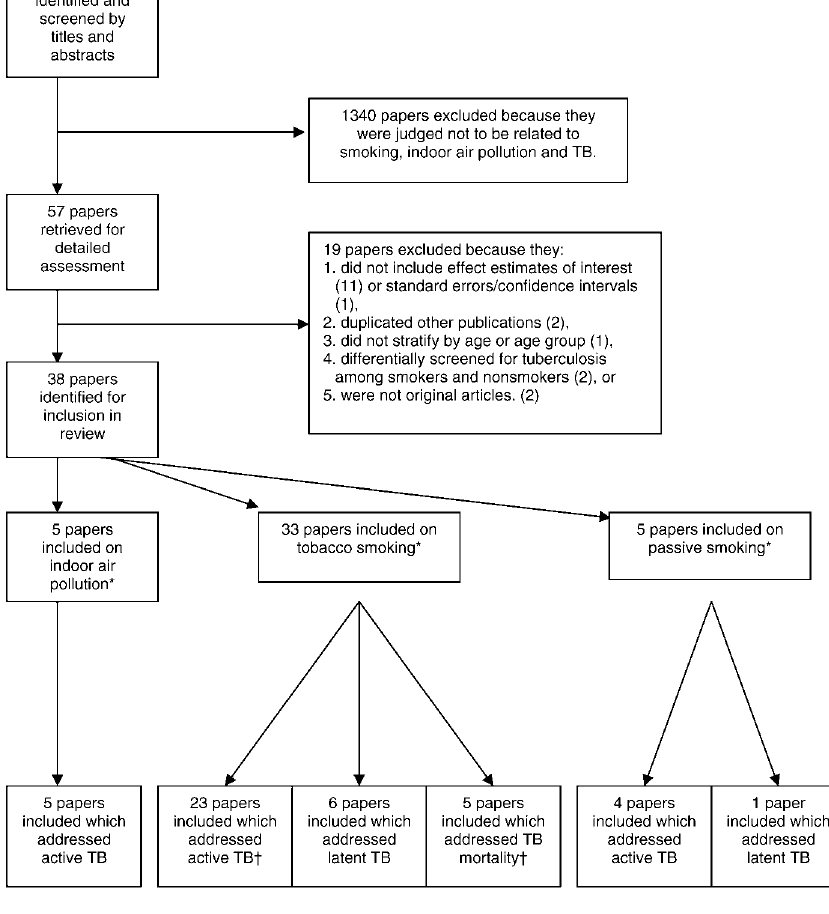
Figure 1. Flow Diagram of Study Steps and